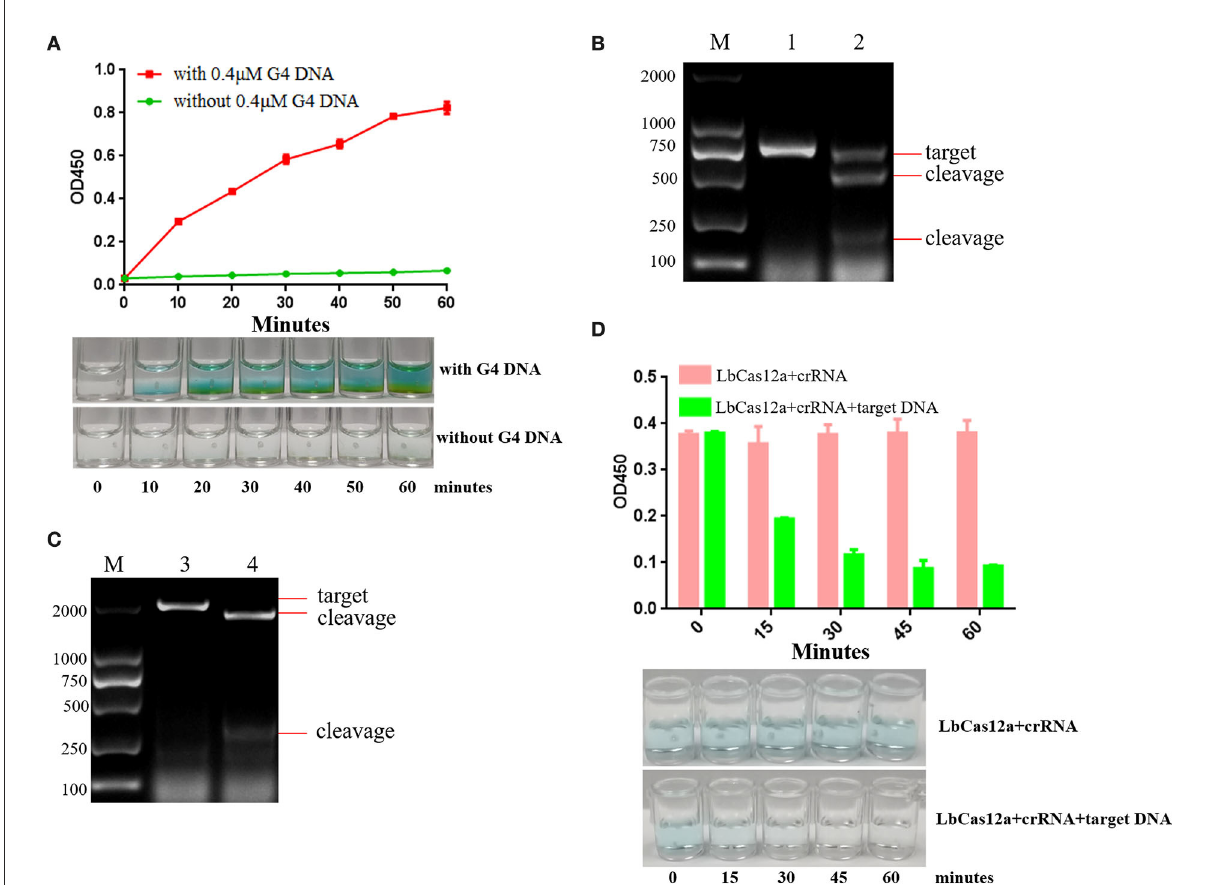
FIGURE2 The analysis of optimal reaction time and target DNA sequence. (A) TMB is catalyzed by 0.4 µ M G-quadruplex and 2 µ M hemin. The color gradually deepened with the increase of time, and the green color could be observed after incubation at 37 ◦ C for 20min. (B) crRNAs were designed and synthesized according to the PCV2 Cap protein gene, and the cleavage efficiency of crRNA targeting PCV2 Cap was analyzed. Lane M: 2000 DNA ladder; Lane 1: negative control, PCV2 Cap gene was cut by ASFV crRNA and Lbcas12a; Lane 2: PCV2 Cap gene was cut by PCV2 crRNA and Lbcas12a. (C) crRNA was designed and synthesized according to ASFV VP72 protein gene, and the cleavage efficiency of crRNA targeting ASFV VP72 was analyzed. Lane M: 2000 DNA ladder; Lane 3: negative control, ASFV VP72 gene was cut by PCV2 crRNA and Lbcas12a; Lane 4: ASFV VP72 gene was cut by ASFV crRNA and Lbcas12a. (D) Evaluation of the efficiency of trans-cleavage G-quadruplex ssDNA by LbCas12a with crRNA over